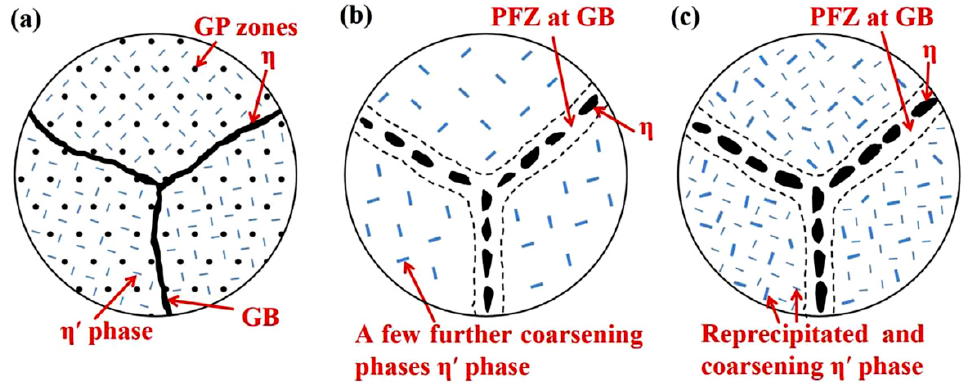
Figure 18. Microstructure changes near grain boundaries during RRA treatment: ( a ) pre-aging ( b ) retrogression ( c ) re-aging. (Reprinted with permission from ref. [36]. Copyright 2020 Elsevier).